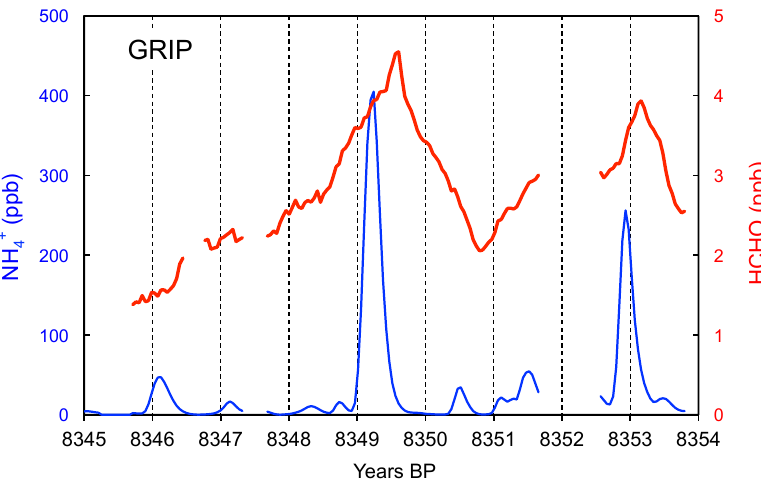
Figure 4. An example of formaldehyde (HCHO) perturbations detected at Summit (GRIP deep ice core) along two ammonium events.